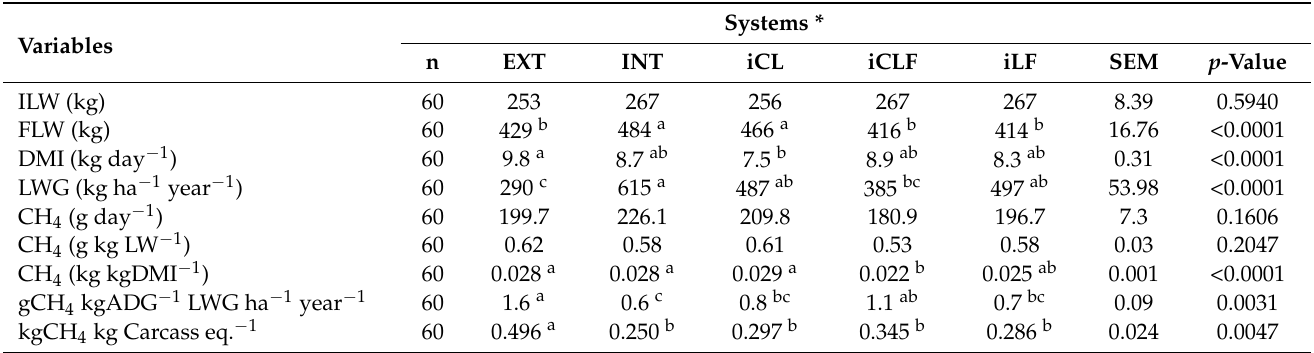
Table 4. Performance variables and CH 4 emission of cattle raised in different pasture production systems in Brazil southeast (means of two